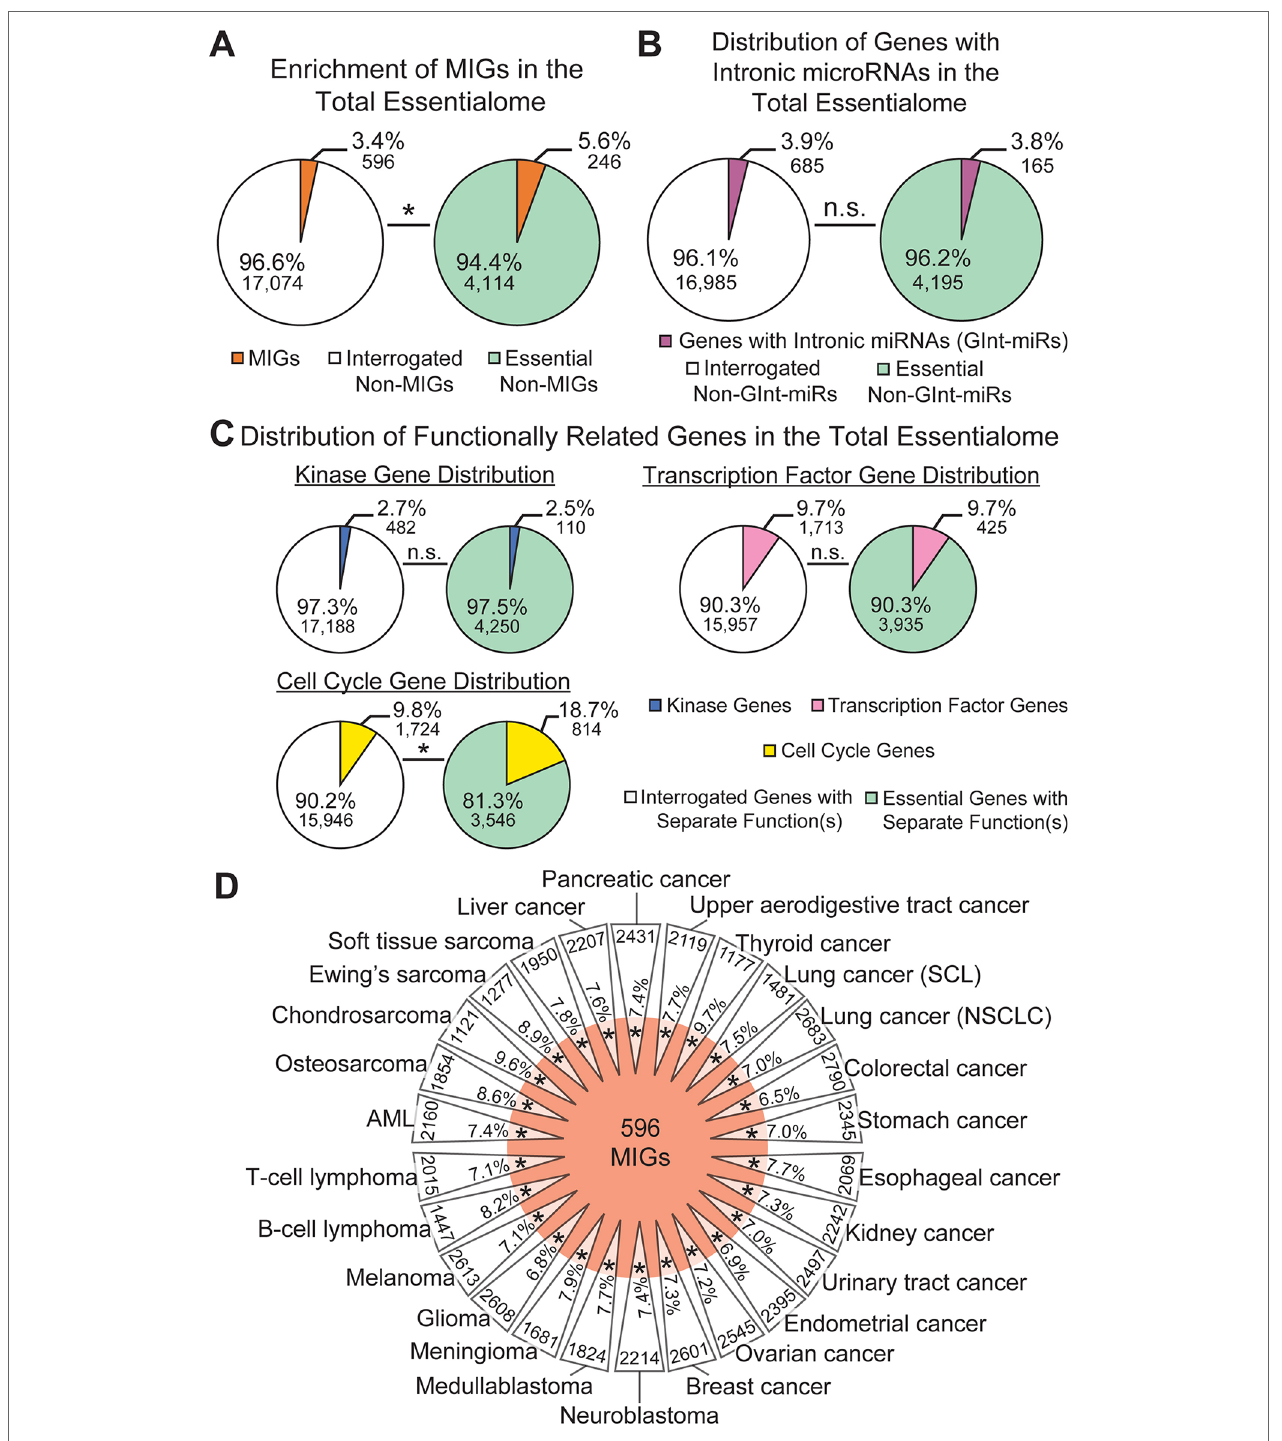
FIGUrE 2 | Minor intron-containing gene (MIGs) are enriched in the essentialome. (A) Pie charts showing the percentage of MIGs (orange) in all genes interrogated (left) and in all essential genes (right). (B) Pie charts showing the percentage of genes with intronic microRNA genes (GInt-miRs) in all interrogated genes (left) and in the total essentialome (right). (C) Pie charts showing the percentage of genes with kinase activity (top left), transcription factor activity (right), or a role in cell cycle regulation (bottom left) in all interrogated genes and in the total essentialome. (d) Daisy model representing the 26 cancer-type essentialomes (triangular petals) and the 596 MIGs (orange center). The overlap of the center with the petals indicates the enrichment of MIGs in the cell-line essentialomes, with the percentage of MIG enrichment in each petal. Gene number within each cancer-type essentialome is located on the outside of each petal. Statistical significance was determined by Fisher’s exact test. AML; acute myeloid leukemia, SCL; small cell lung cancer, NSCLC; non-small cell lung cancer. N.s., not significant; * P ≤ 5.45E−16.